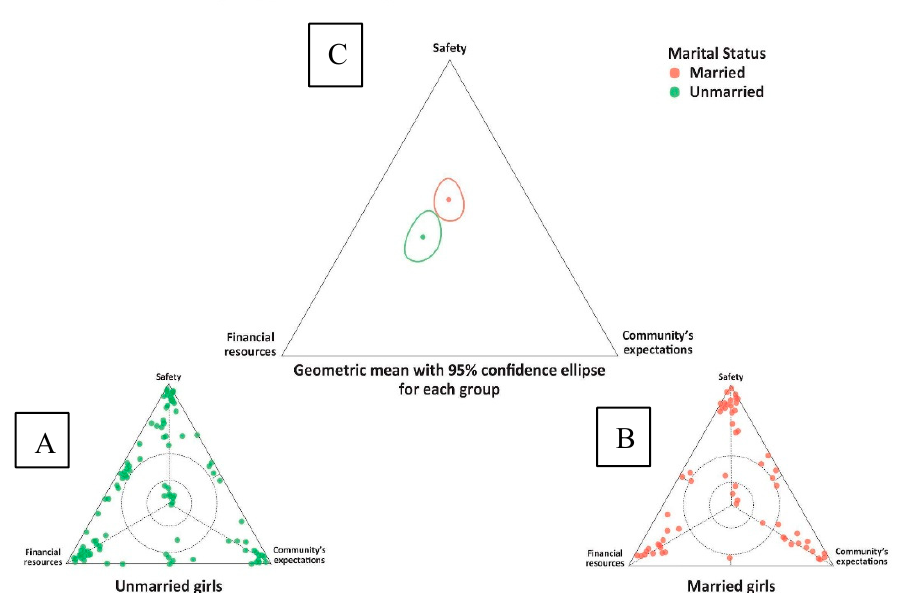
Figure 3. Participant responses for “reasons the events in the story happened”: ( A ) unmarried girls, n = 111; ( B ) married girls, n = 77; and ( C ) the geometric mean and 95% confidence ellipses for all of the responses in the two subgroups.